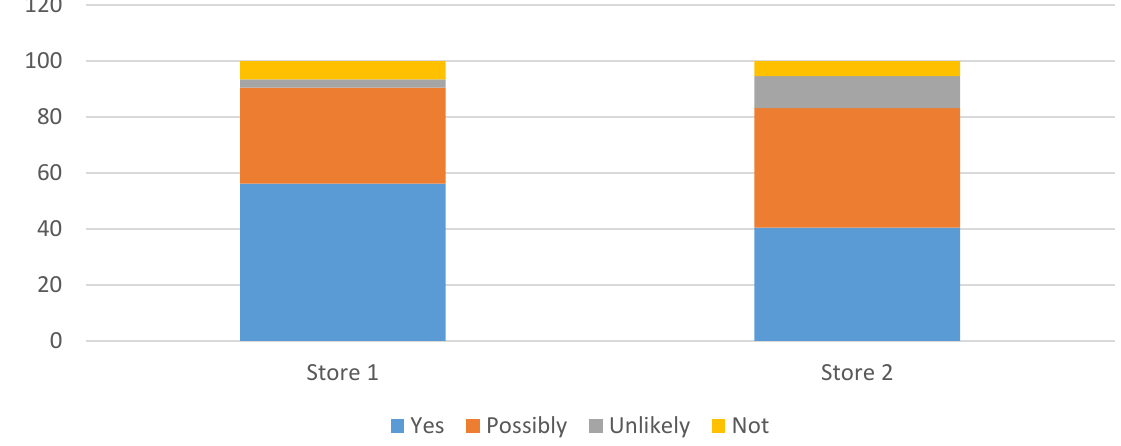
Figure 4. Distribution of the respondents by their intention to make a recommendation to friends